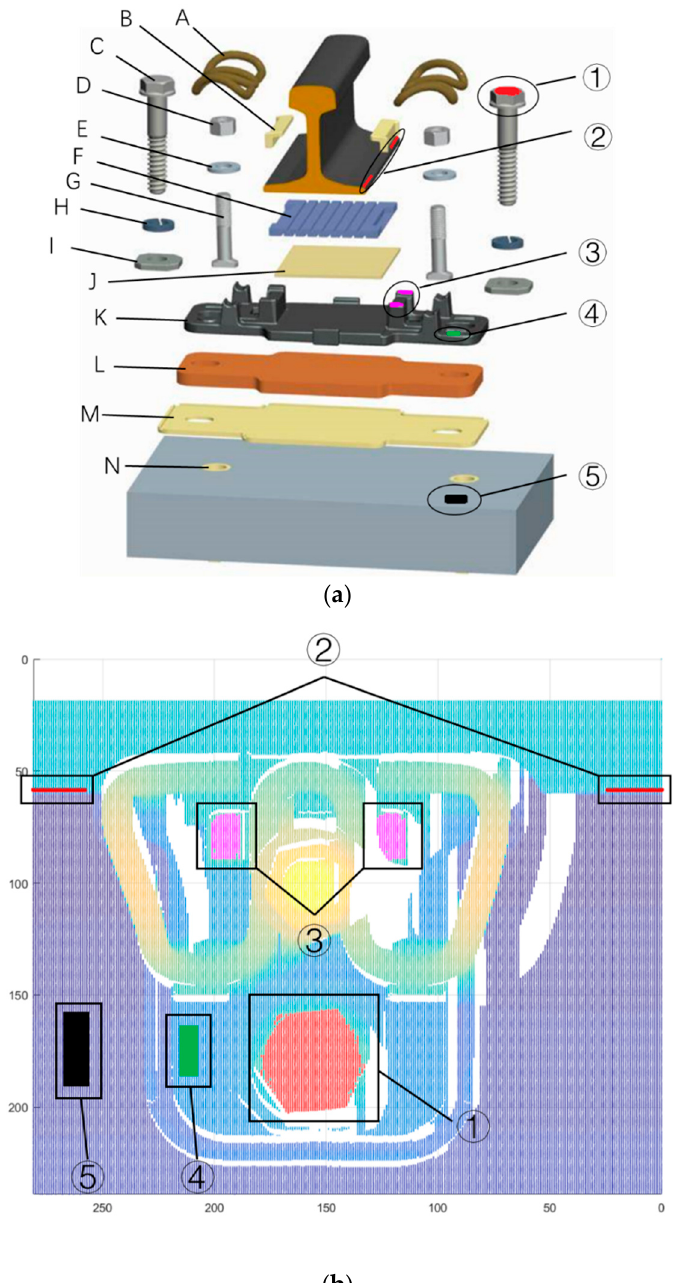
Figure 13. Geometric parameter measurements of the WJ-7 height adjustment pads: ( a ) detailed structure diagram of WJ-7 fastening system. ( b ) corresponding area of interest (AOI) in the point cloud. A: metal clip; B: insolation block; C: anchor bolt; D: nut; E: flat washer; F: rubber pad; G: T-bolt; H: spring washer; I: flat pad; J: height adjustment pad under the rail; K: iron plate; L: height adjustment pad under the iron plate; M: insolation and buffer pad; N: embedded bushing. ① Upper surface of anchor bolt; ② Rail bottom edge points; ③ Upper surface of the iron plate limit pillar; ④ Iron plate detection area; ⑤ Rail pad detection area.